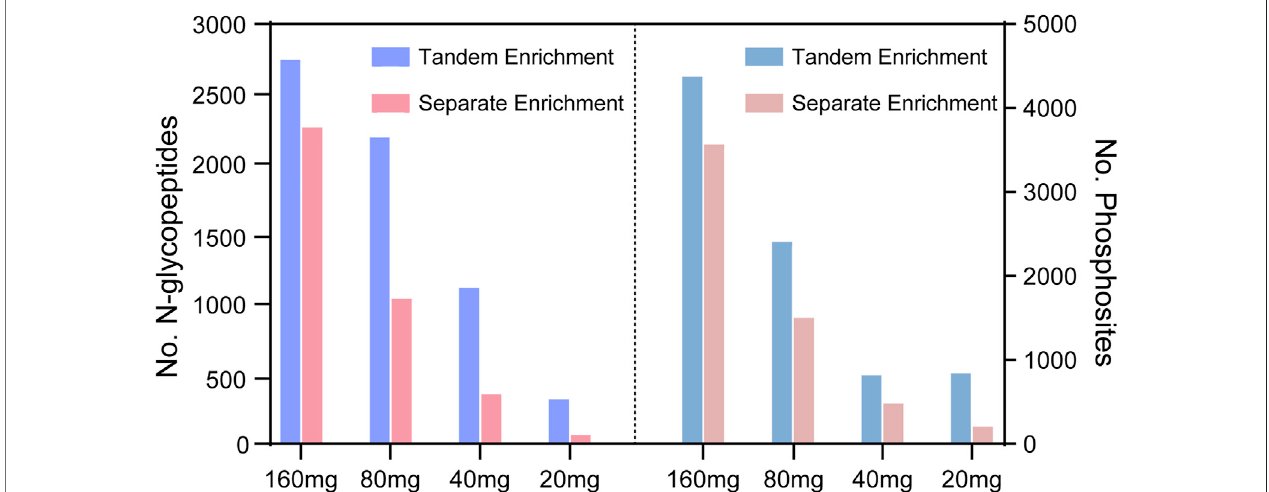
FIGURE 4 | N-glycopeptides and phosphosites obtained from tandem enrichment and separate enrichment of using 160, 80, 40 and 20 μ g peptides.